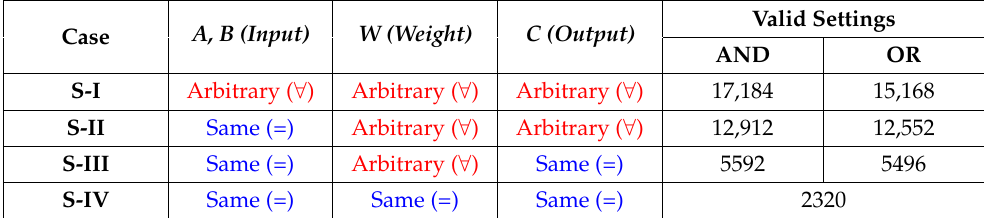
Valid Settings AND OR